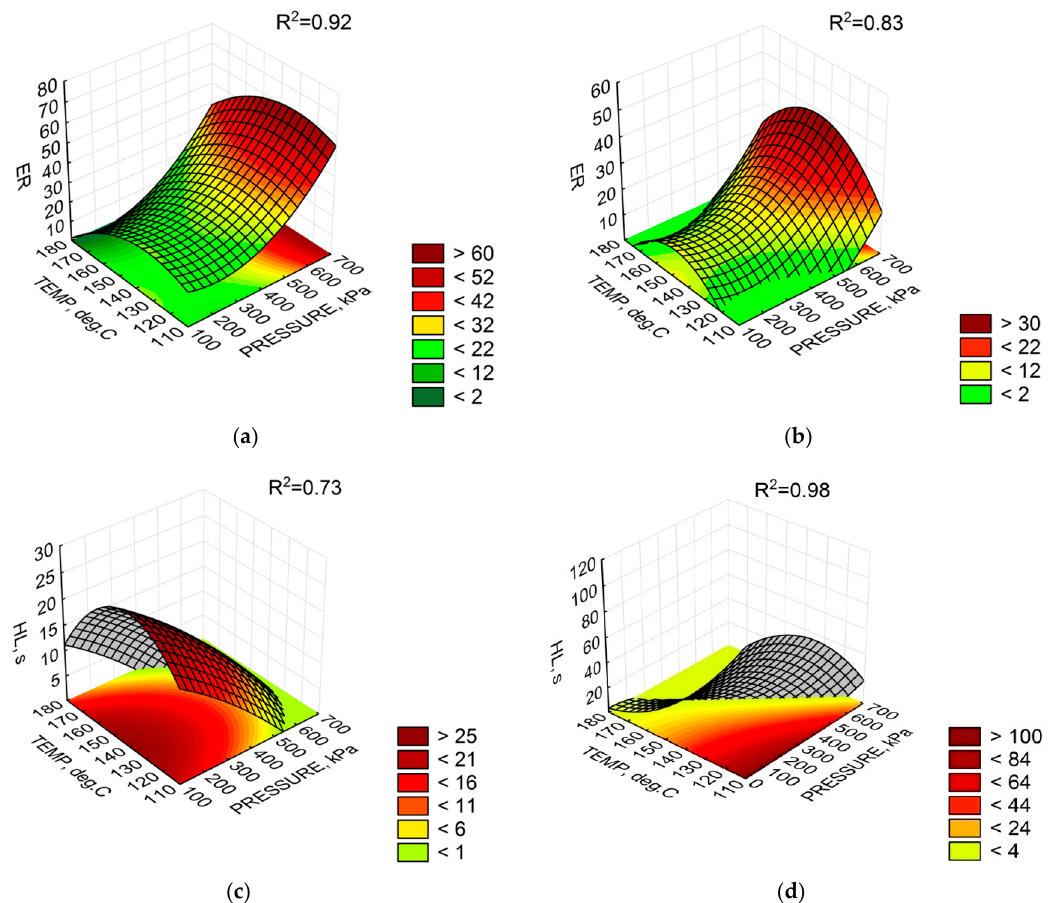
Figure 4. Response surface of foam parameters (2.5% water amount): ( a ) expansion ratio (ER), 50/70; ( b ) expansion ratio (ER), 50/70 M; ( c ) half-life (HL), 50/70; and ( d ) half-life (HL), 50/70 M.